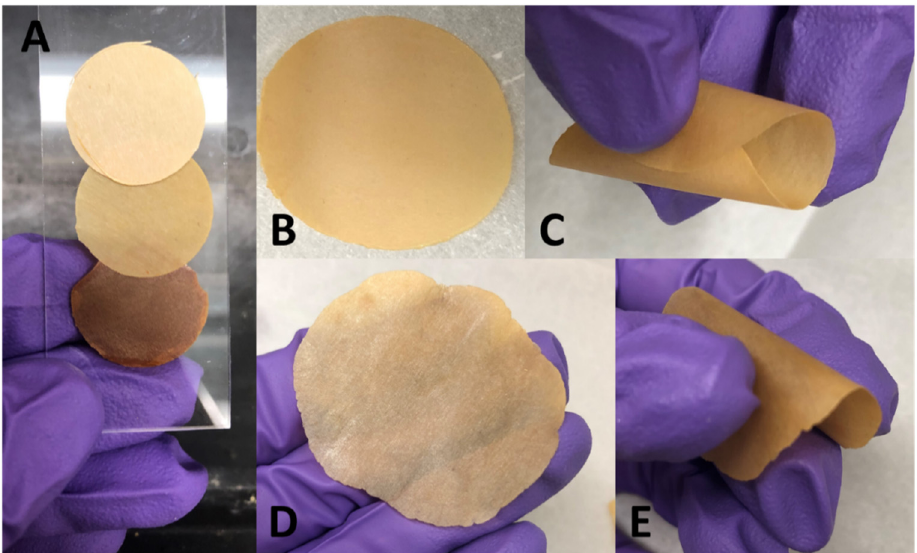
Figure 6. Images of ionenes containing [BTA(MeIm + ) 3 ][Tf 2 N - ] 3 . ( A ) ¾” disks of composite films showing opacity; ( B , C ) [TC API pX][Tf 2 N]:[BTA(MeIm + ) 3 ][Tf 2 N - ] 3 cast as 2.5” disk, showing flexibility without creasing or adhesion, ( D , E )) [TC I4A pX][Tf 2 N]:[BTA(MeIm + ) 3 ][Tf 2 N − ] 3 cast as 2.5” disk, showing flexibility when bent.